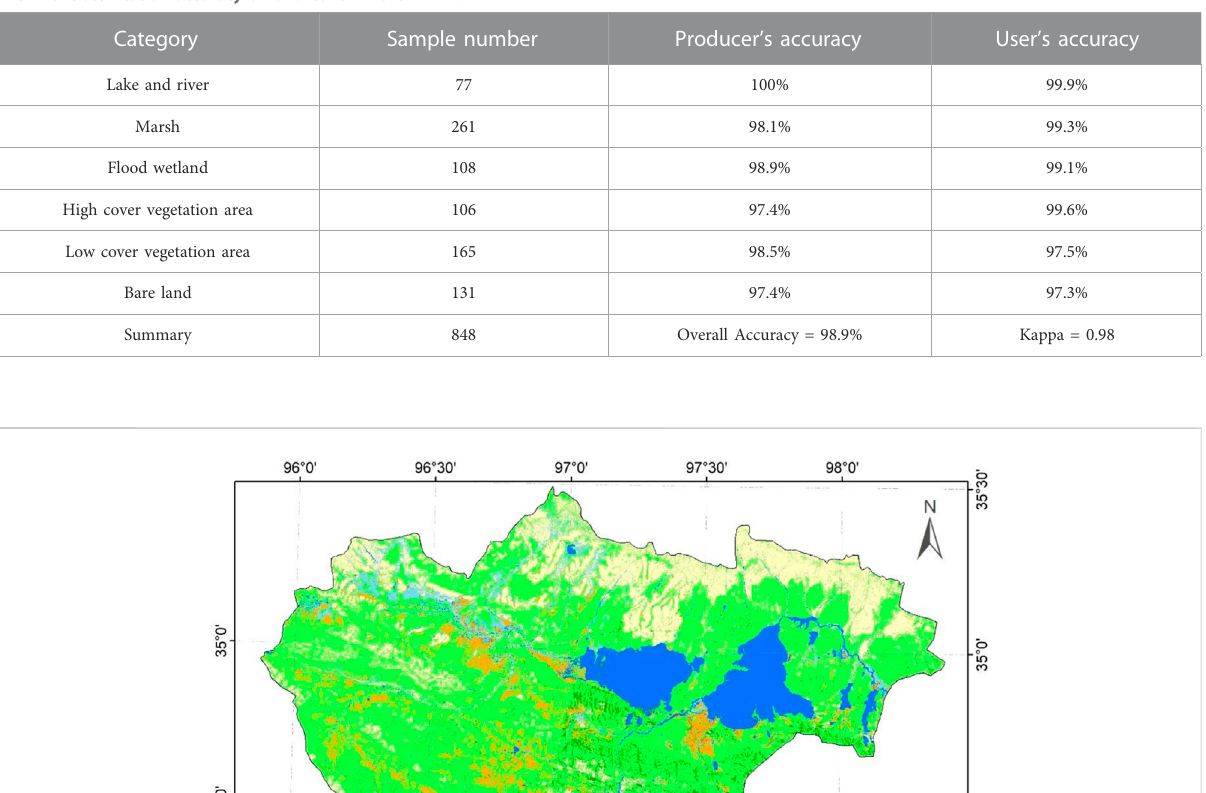
TABLE 5 Classi fi cation accuracy of land cover in the HAYR.